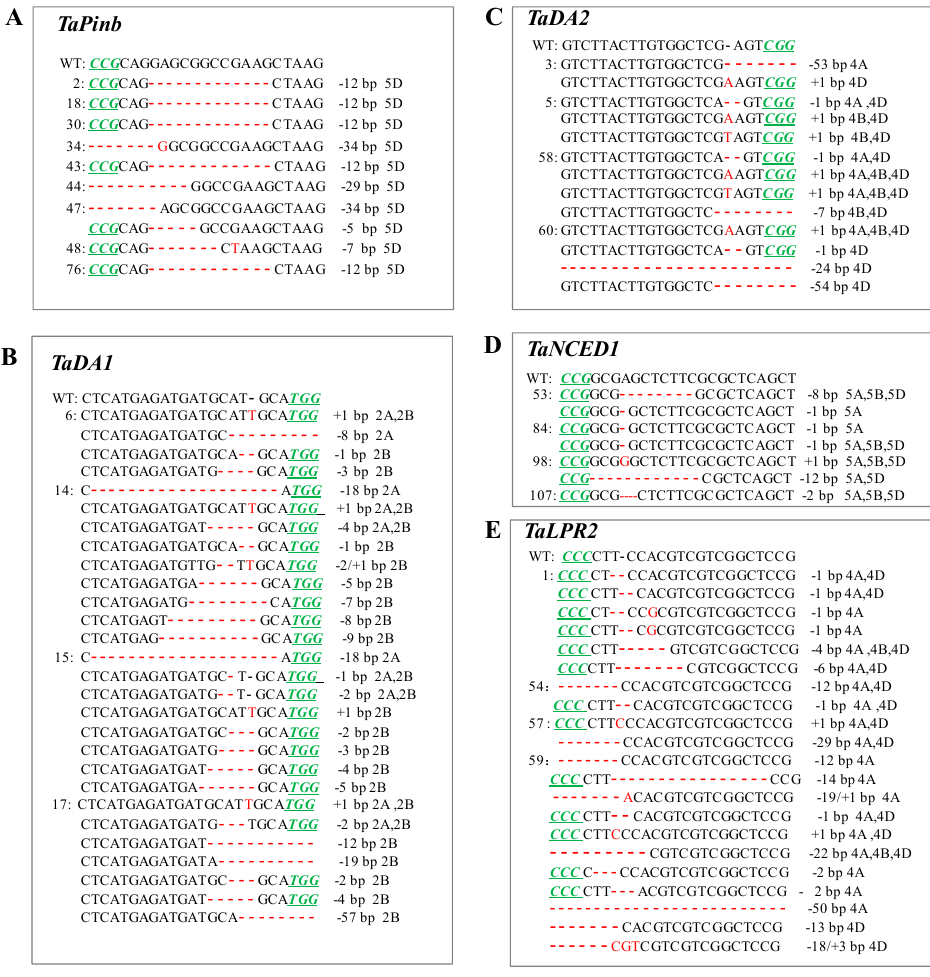
Figure 3. CRISPR/Cas9 ‐ induced targeted mutagenesis of the target genes TaPinb ( A ), TaDA1 ( B ), TaDA2 ( C ), TaNCED1 ( D ) and TaLPR2 ( E ) in T1 plants. The mutation sites are indicated in red. The PAM (NGG) sites are underlined and indicated in italics in green.